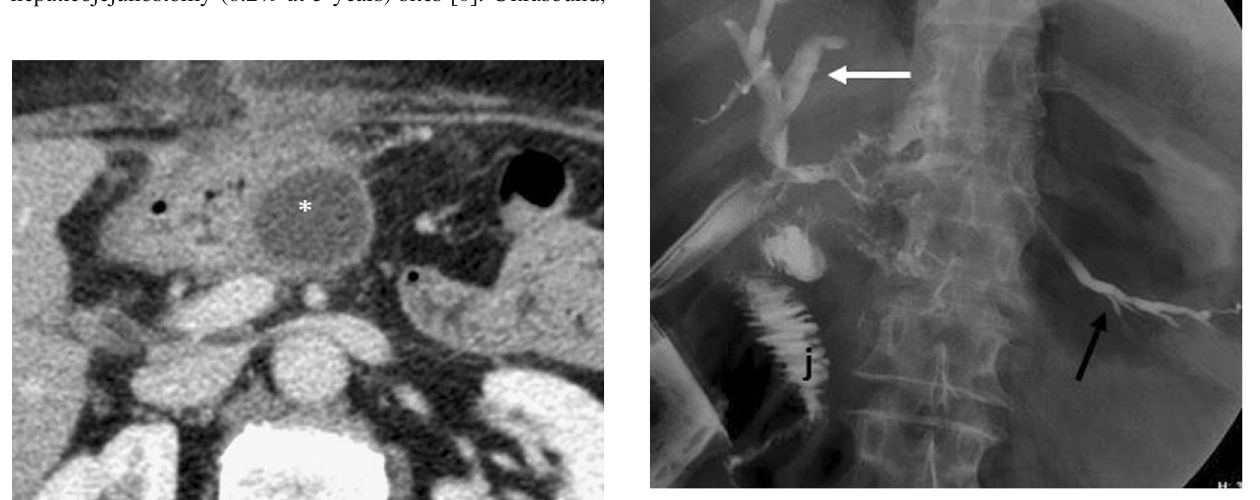
Fig. 25 Spot image obtained during fistulography shows the passage of contrast medium through the biliary anastomosis inside the jejunal loop (j), a finding diagnostic for an anastomotic dehiscence. The biliary tree (white arrow) and the main pancreatic duct (black arrow) are also visible